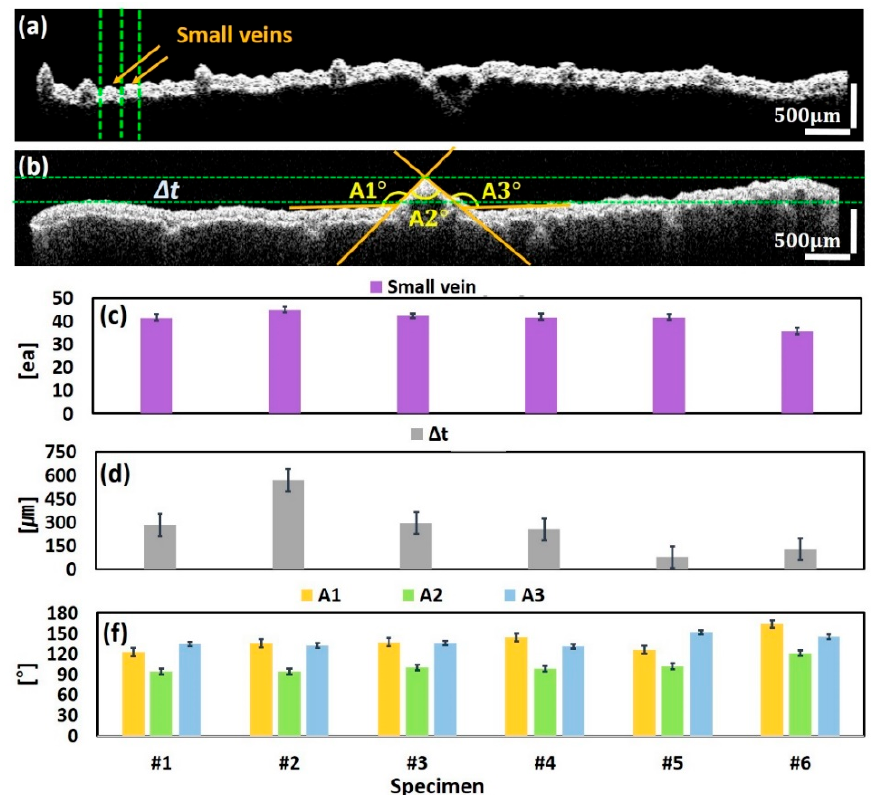
Figure 6. ( a ) Graphical description of the measurement procedure of small vein numbers. ( b ) The flipped 2D-OCT visualization acquired from the rear surface of the leaf specimen illustrating external bi-directional angles between lower epidermis layer and lower mid-vein (A1 and A3), and internal angle of lower mid-vein (A2). ( c ) Quantitative graphical representation of enumerated small vein information. ( d ) The thickness between lower epidermis layer and lower mid-vein ( ∆ t ). ( e ) Quantitative graphical representation of angular information. (The error bars are the standard